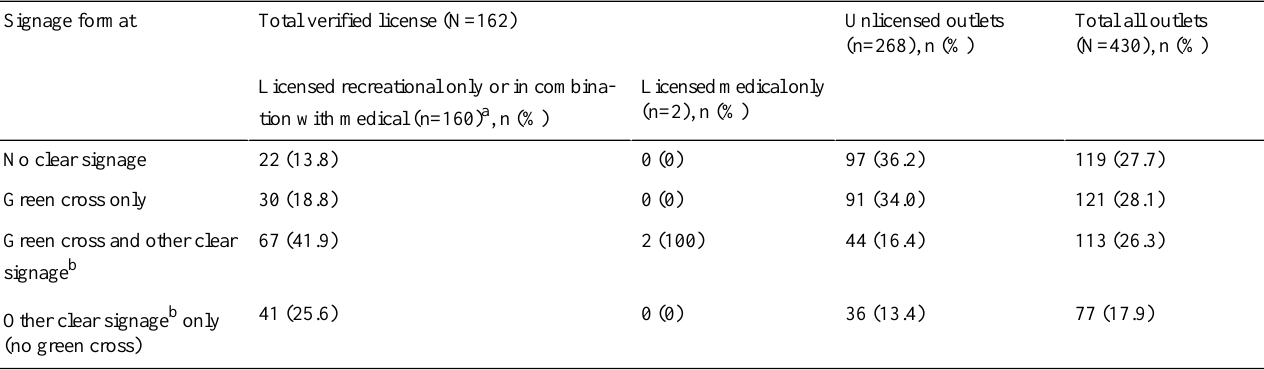
Table 2. Indicator of clear signage across all formats (storefronts, sidewalk signs, billboard, posters, and murals) and by license status (Table includes cell counts and column percentages).